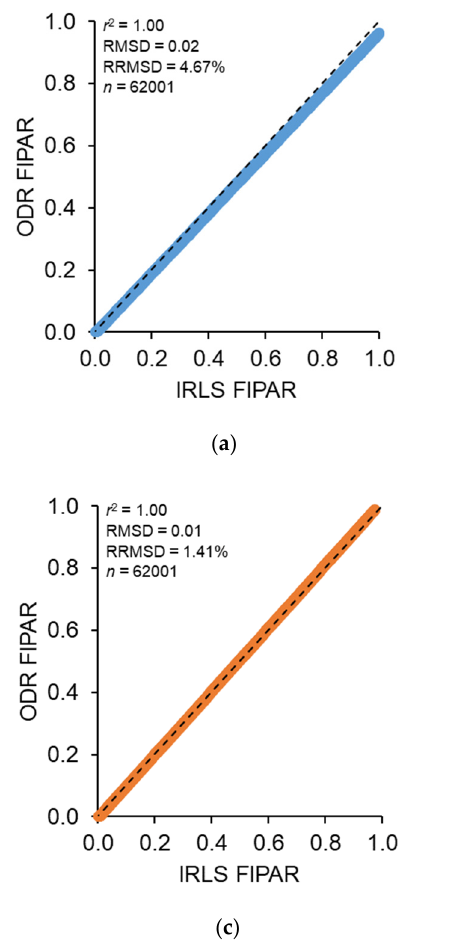
Figure 11. Comparison between ODR- and IRLS-based high-spatial-resolution reference maps of FIPAR ( left ) and CCC ( right ) for the Las Tiesas–Barrax ( a , b ) and Wytham Woods ( c , d ) campaigns. The dashed line represents a 1:1 relationship.